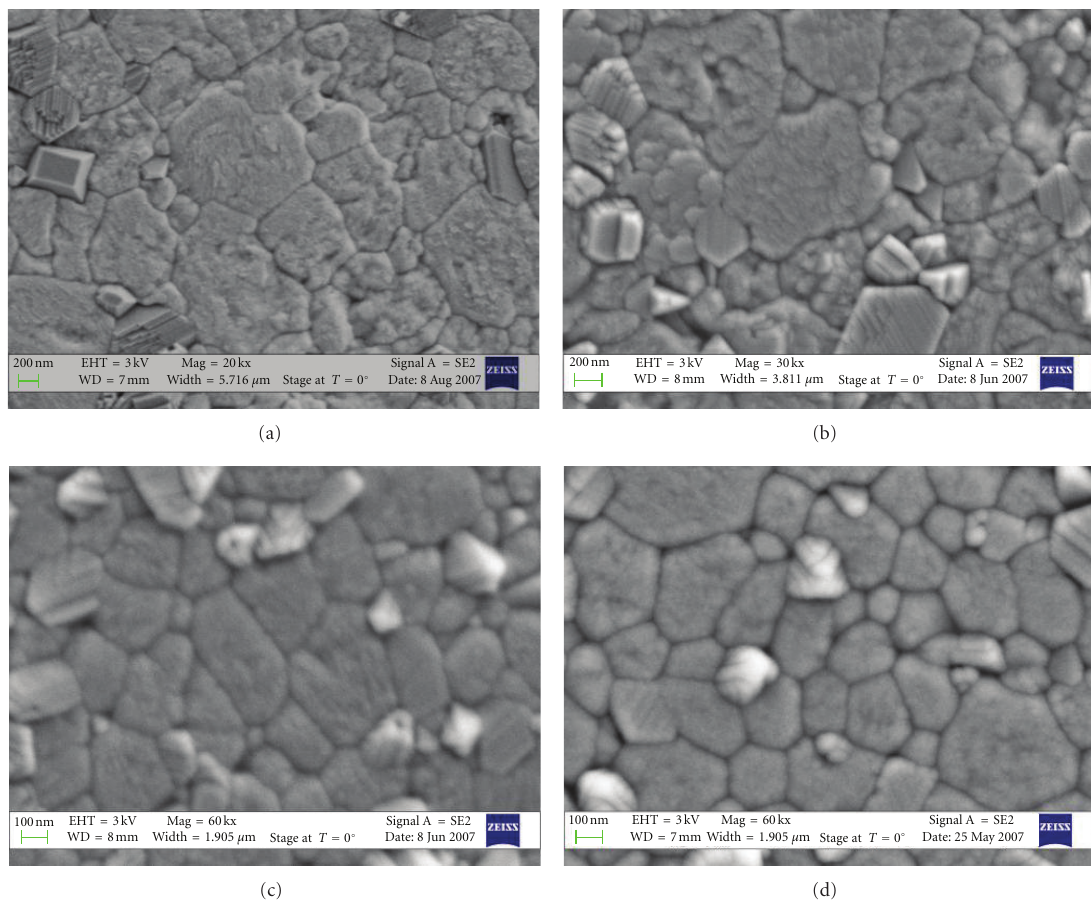
Figure 7: Microstructures of ME composites with varying grain size (a) 830 nm, (b) 758 nm, (c) 111 nm, and (d)